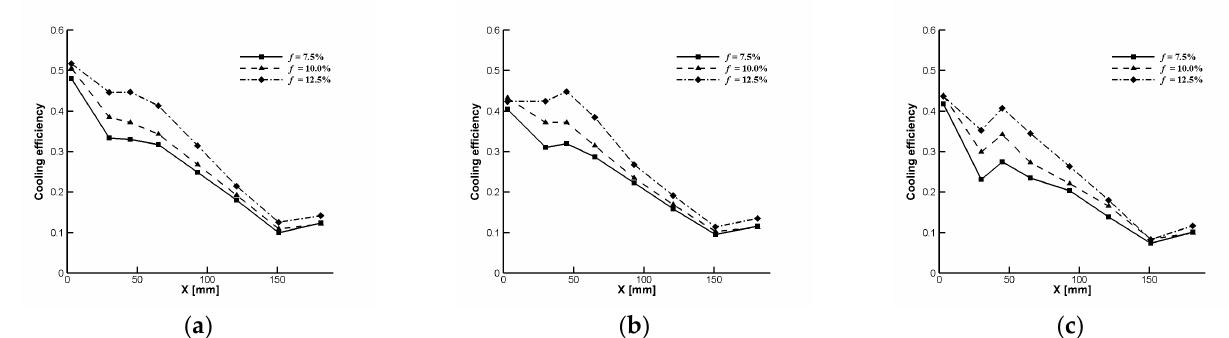
Figure 6. Variations of the cooling efficiency along the axis direction ( H = 0.3 mm, θ = 6.37°). ( a ) α = 0°. ( b ) α = 15°. ( c ) α = 30°.